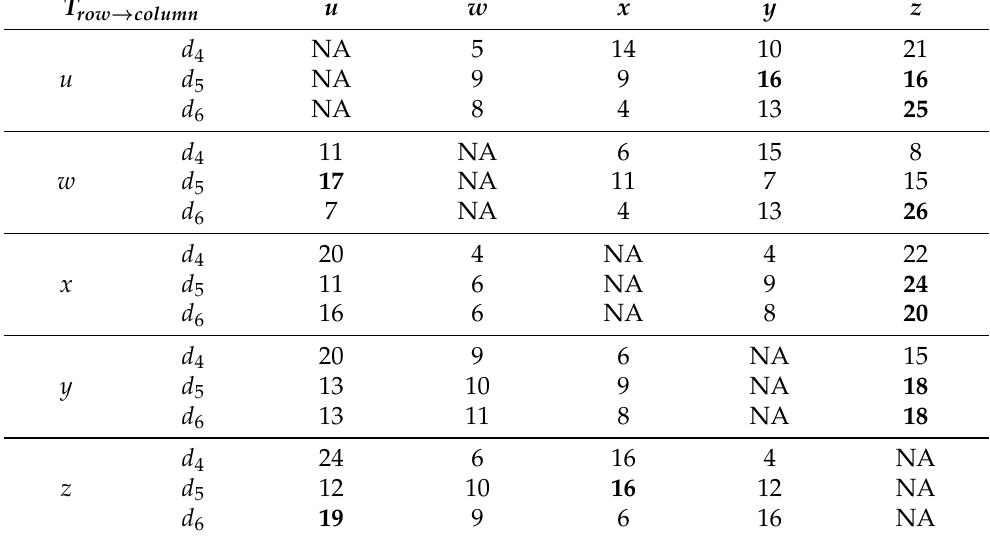
Table 4. Sum of cases where the Transfer Entropy coefficient in a row for a given variables pair is the highest—1st variant (50